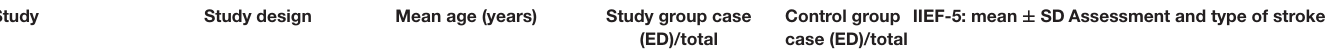
TABLE 1 | Characteristics of the 20 included